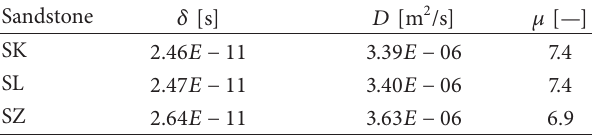
Table 8: Water vapor transport properties, wet cup